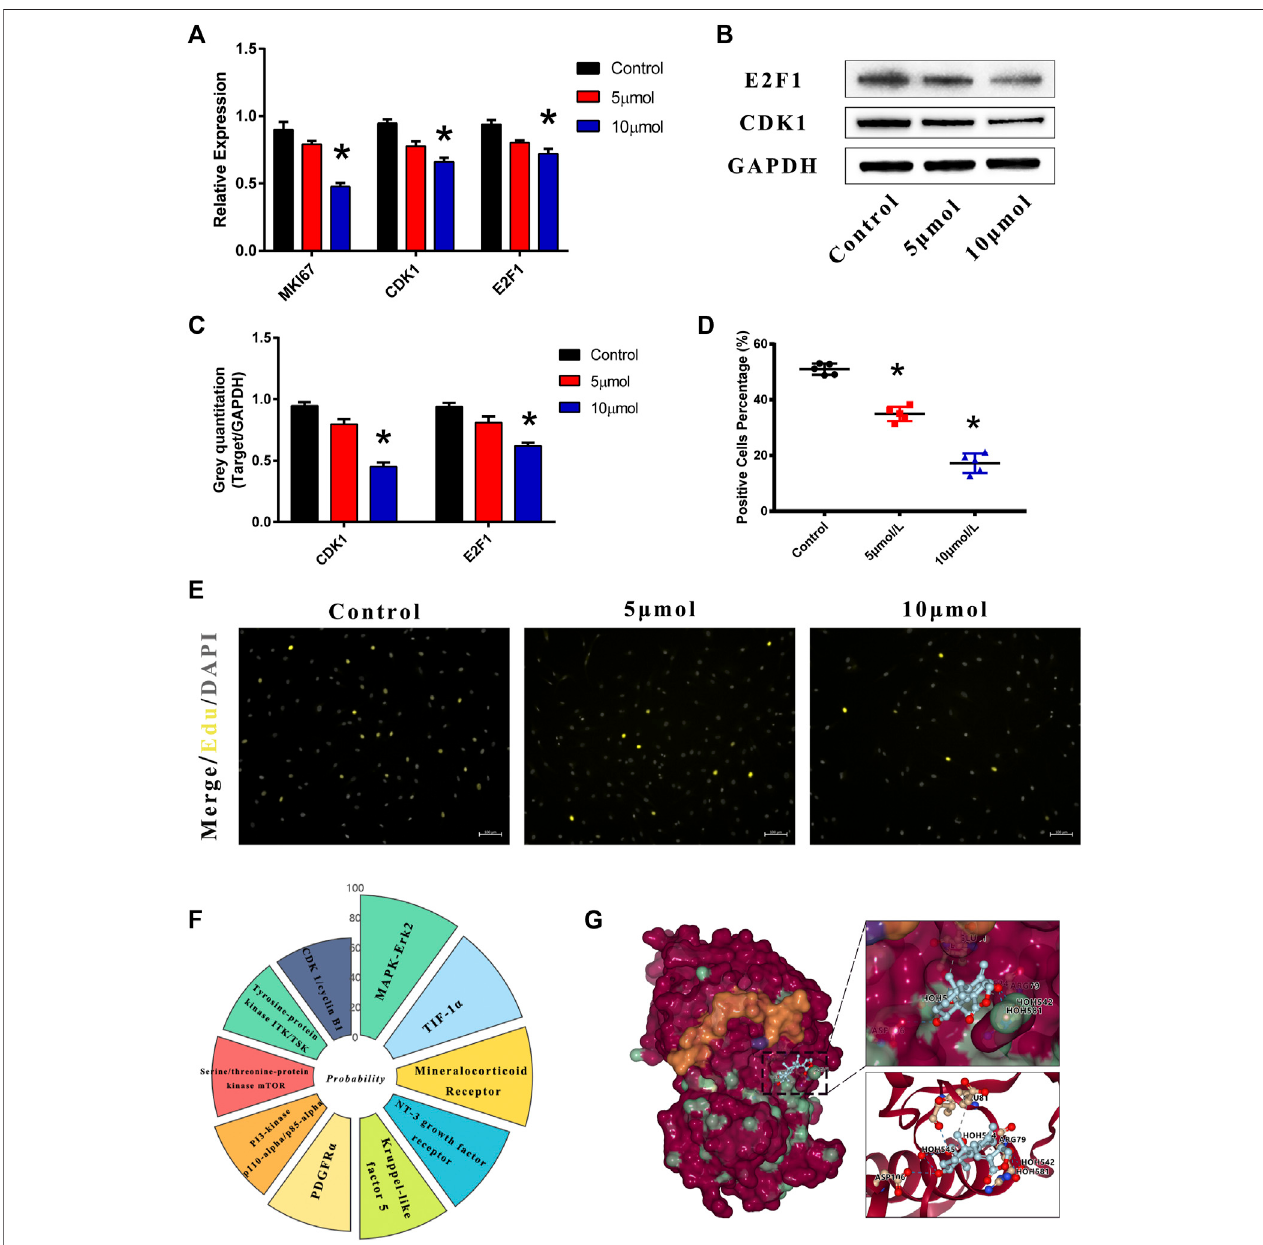
FIGURE 3 | AGP downregulated the cell proliferation genes and protein expression levels. Predicted molecular targets and docking of AGP. (A) AGP (5 and 10 μ mol/L)inhibitedgeneexpressionlevelsof CDK1 , E2F1 ,and MKI67 . (B) AGP(5and10 μ mol/L)inhibitedproteinexpressionlevelsof CDK1 and E2F1 . (C) Analysisof protein expression levels of CDK1 and E2F1. Data are collected by gray semi-quanti fi cation and compared to GAPDH. (*) p < 0.05 (vs control) indicates a signi fi cant difference. (D) Percentage of EdU positive cells. (*) p < 0.05 (vs control) indicates signi fi cant difference. (E) Fluorescence staining of EdU assay in VICs under AGP conditions (yellow). (F) Nightingale rose of probabilities in the top 10 targets from the online tool “ SwissTargetPrediction. ” (G) ERK protein was selected for further molecular docking analysis. AGP successfully accessed the pocket structure of the protein molecule.